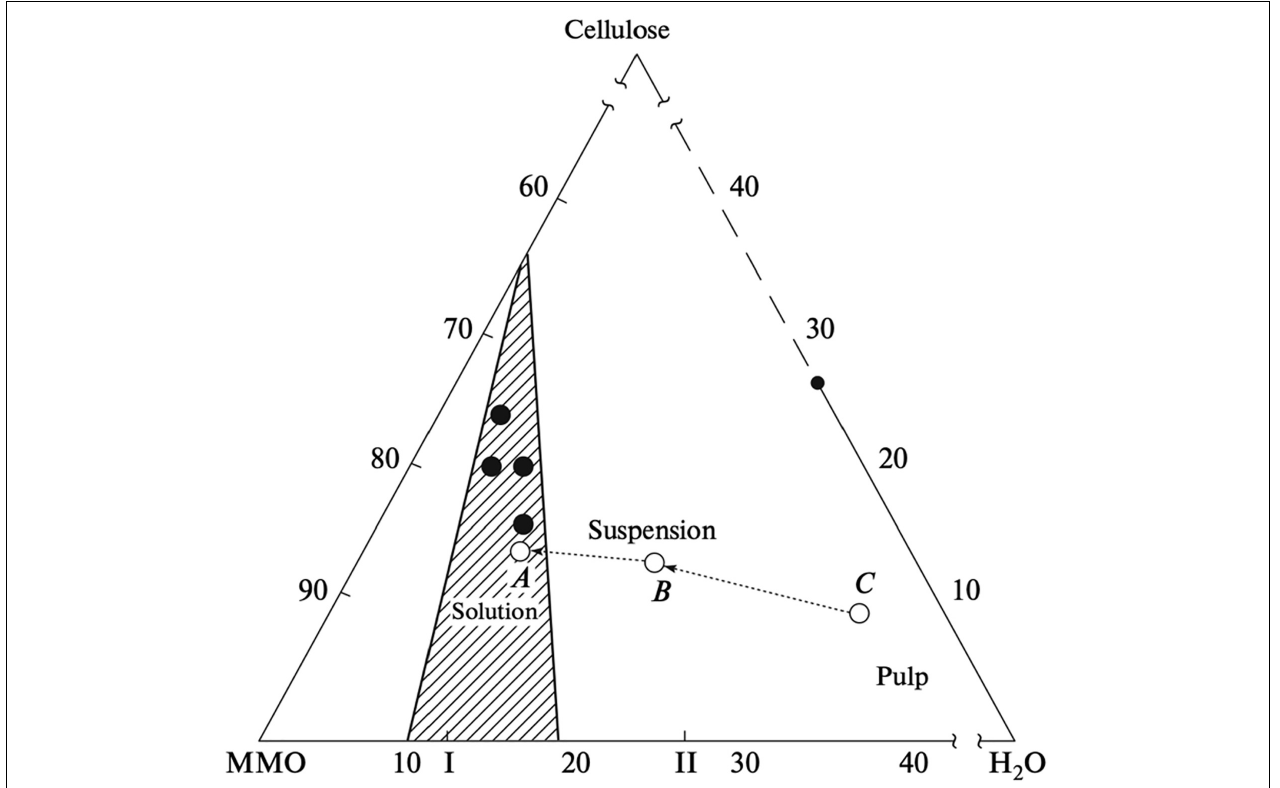
FIGURE 7 | Schematic phase diagram of the cellulose–MMO–H 2 O system: (line CBA) variation in the composition of the system during cellulose dissolution via the traditional MMO process; (closed circles) composition of the system during cellulose dissolution via the solid-phase MMO process; (I) MMO monohydrate and (II) MMO 2.5-hydrate (Golova et al.,